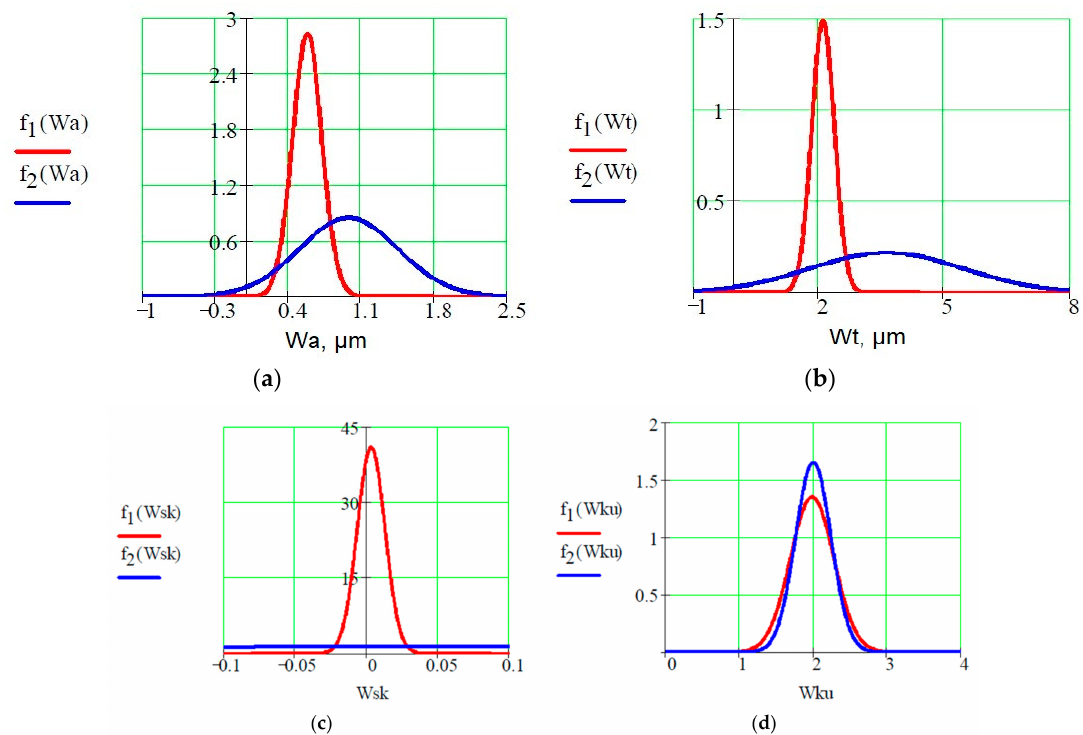
Figure 6. Normal distribution of probability densities; f1(Wa), f1(Wt), f1(Wsk), f1(Wku)-probability